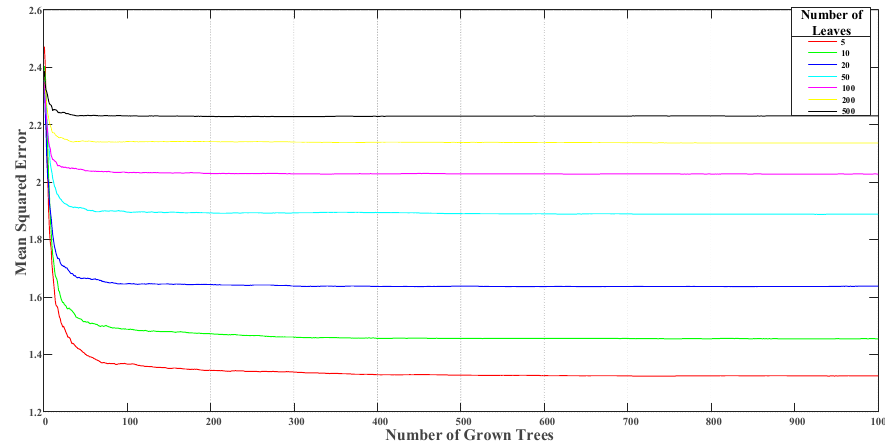
Figure 8. Parameter selection of random forest (cleaning rate 95.97%).